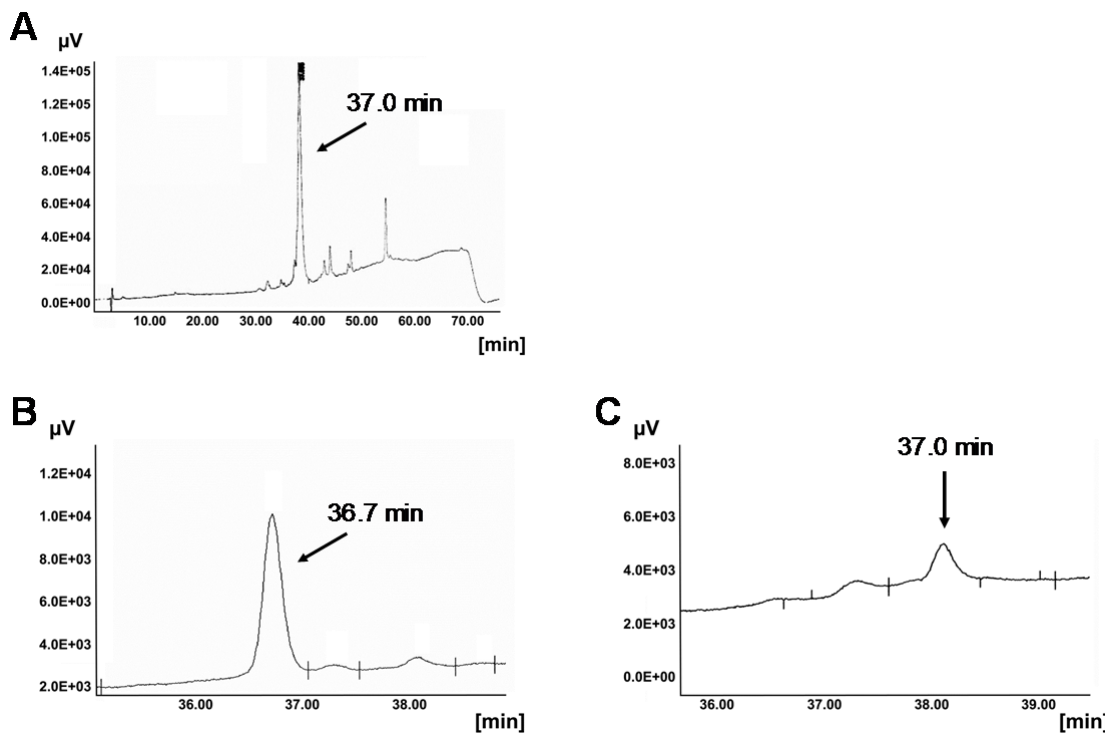
Figure 2. Proteolytic degradation of MPG β by COS-7 cells. A: MPG β in the absence of cells. HPLC elution profiles of MPG β after incubation with COS-7 cells were obtained under described conditions (gradient 10 to 90% acetonitrile). Cleavage of MPG β by secreted and surface bound proteases was measured after 15 min (B) and 60 min (C) of incubation in the presence of intact